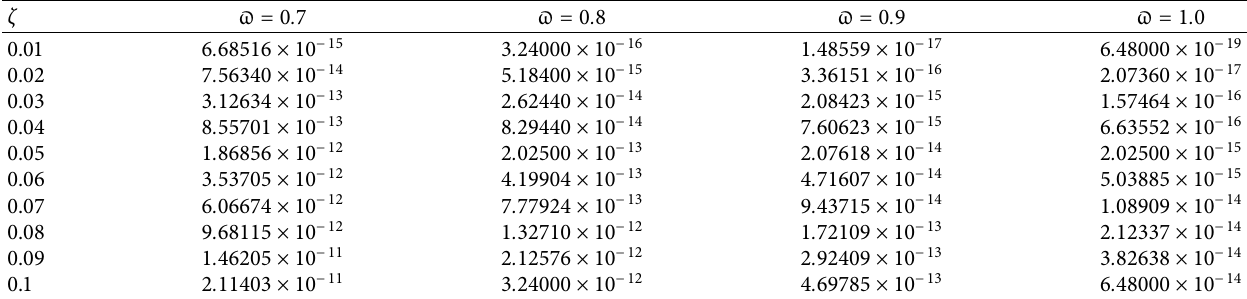
Table 4: | w 5 ( ϰ , ζ ) − w 4 ( ϰ , ζ )| of Problem 2 at diferent values of ϖ at ϰ � 1 . 0 determined by LRPSM at plausible locations in the range ζ ∈ [ 0 , 0 . 1 ] .